Question: Condense the content of this figure into a single sentence.
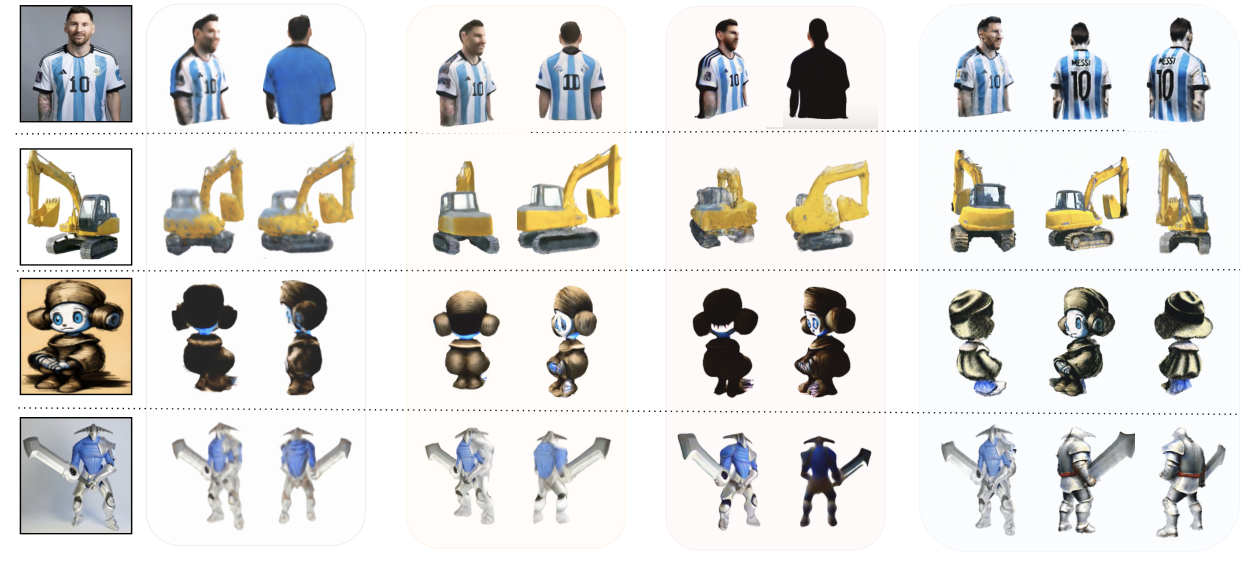
Answer: DTC123 can generate high-fidelity and multiview-consistent 3D assets from a single arbitrary image, significantly enhancing the original SDS pipeline through the diffusion time-step curriculum.